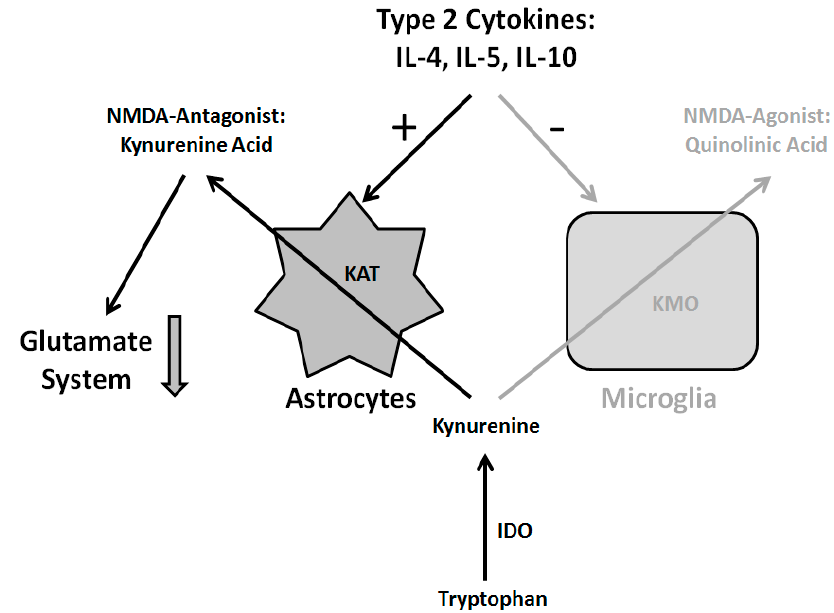
Figure 4. Immune hypothesis of schizophrenia: The type 2 cytokines interleukins (IL)-4, IL-5 and IL-10 activate astrocytes and inhibit microglia. Astrocytes, in turn, produce the glutamate antagonist kynurenic acid which leads to a reduction of glutamate signaling accompanied by disturbances of the dopamine system. For details see text. Abbreviations: kynurenine aminotransferase (KAT), kynurenine (3)-monooxygenase (KMO), indoleamine (2,3)-dioxygenase (IDO), N -methyl- D -aspartate (NMDA). 17